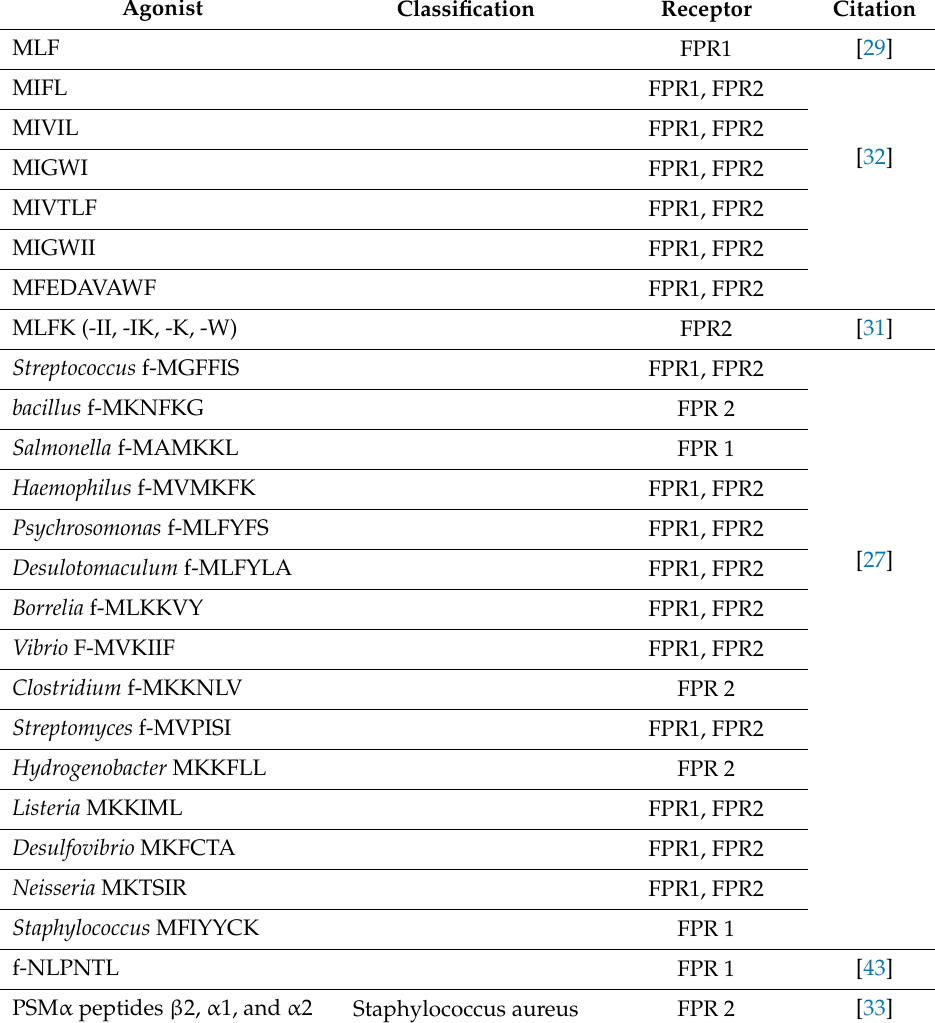
Table 1. Formylated bacterial peptide agonists for formylpeptide receptors (FPRs) (Fprs). Agonist Classification Receptor Citation